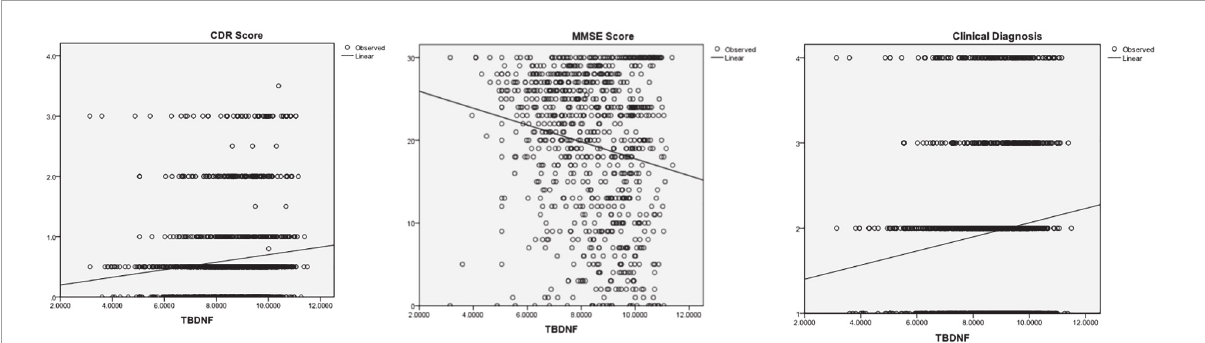
FIGURE1 The correlations between Brain-Derived Neurotrophic Factor (BNDF) and Clinical Dementia Rating (CDR), Mini Mental State Examination (MMSE), and clinical diagnosis.